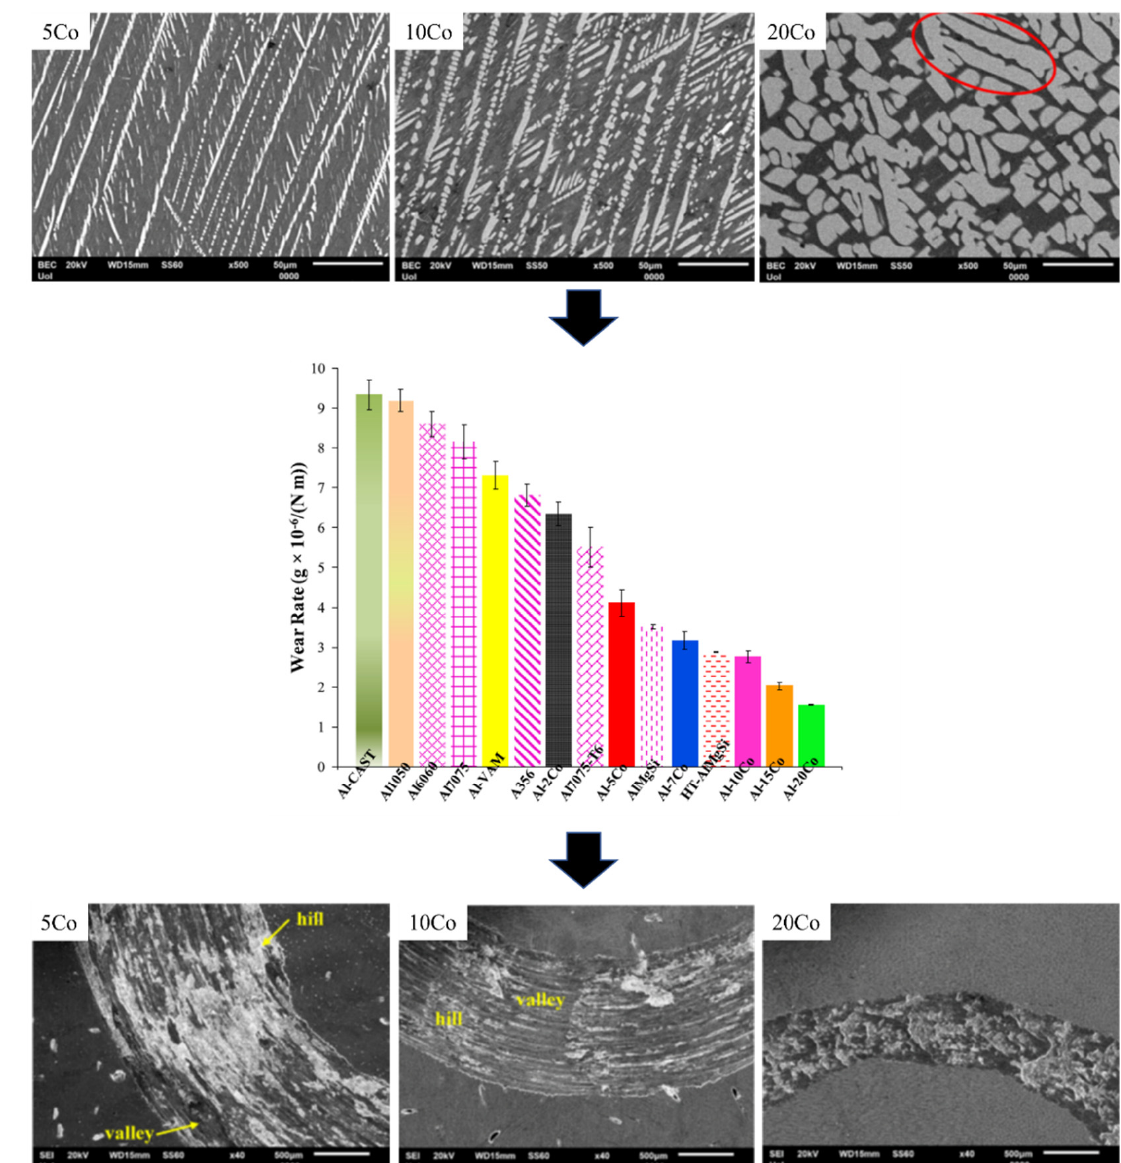
Figure 6. SEM images of Al-5 wt %Co, Al-10 wt %Co and Al-20 wt % Co (Red eclipse: side branching) as fabricated by vacuum arc melting and after sliding wear (ball on disk, 1000 m sliding distance, AISI 52100 steel counter body). Wear rates for Al-Co alloys (2-20 wt % Co) under sliding wear compared to various commercial Al alloys (Al1050, Al6060, Al7075, Al7075-T6, A356, AlMgSi) (Reprinted with permission from [35], Copyright 2022, Elsevier.)